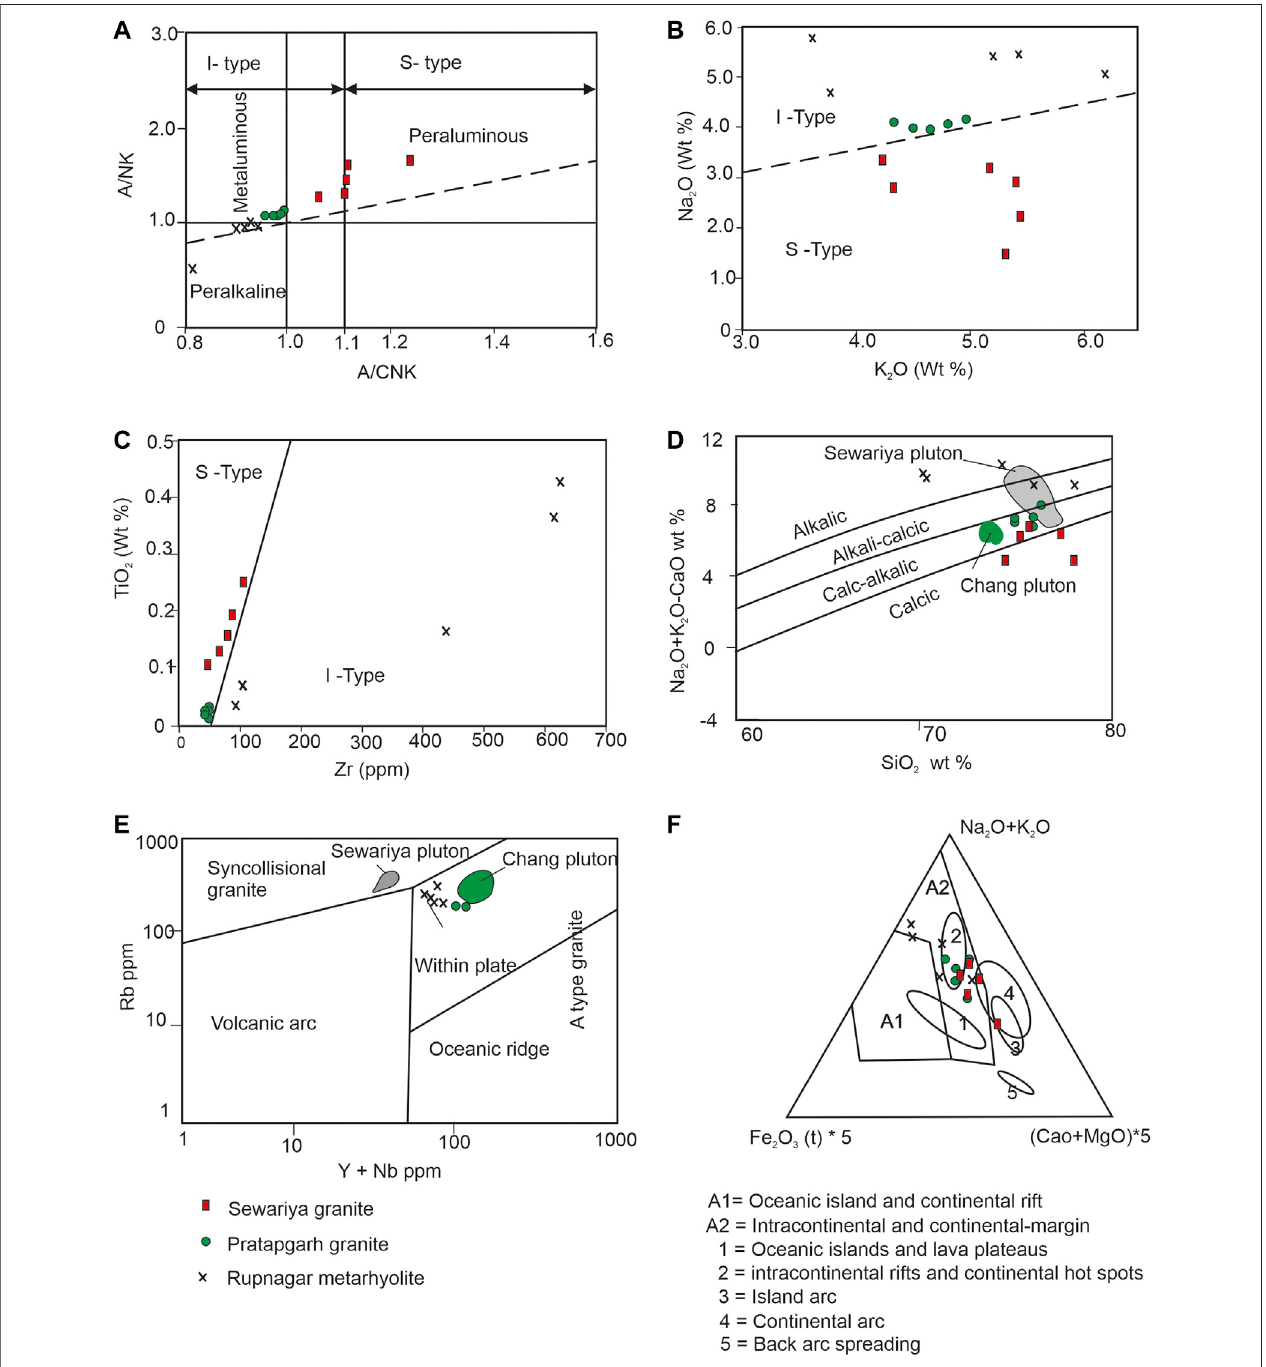
FIGURE 5 | (A) A/NK vs. A/CNK plot, (B) Na 2 O vs. K 2 O, (C) TiO 2 vs. Zr plot, peraluminous, meta-aluminous, peralkaline, I type, S type granite fi elds are after Chappelland White(1992), (D) Na 2 O+K 2 O-CaO vs. SiO 2 plot, alkalic-alkali-calcic, calc-alkalic, and calcic fi elds areafter Frost et al.(2001), (E) Rb vs. Y+ Nbplot within plate,syncollisional,volcanicarc,oceanicridgegranite fi eldsareafterPearce(1996), (F) Na 2 O+K 2 O – (CaO+MgO)*5Fe 2 O 3 (t)*5ternaryplot, fi eldsofA1,A2,rift,island arc granites are after Grebennikov (2014).The fi elds of Chang and Sewariya plutons in Fig. 5D and 5E are after Tiwana et al., 2019 and Ray et al. (2015), respectively.